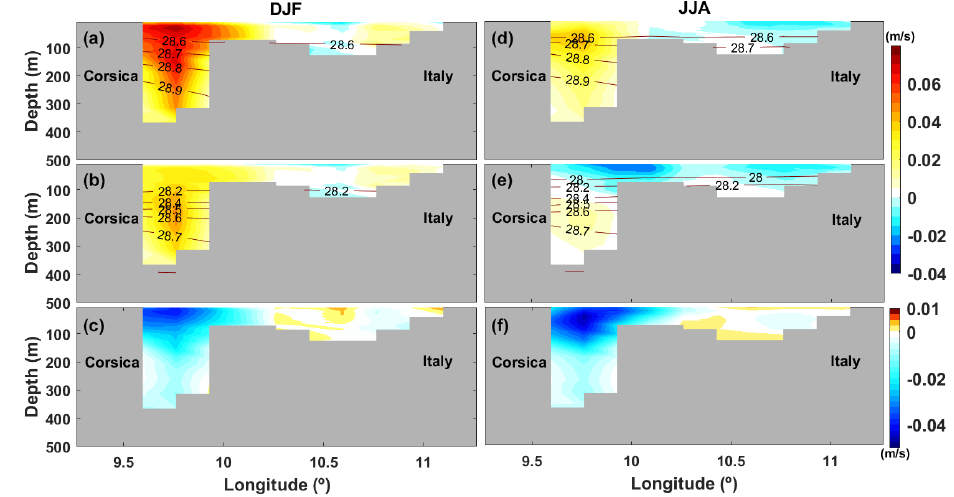
Figure 5. Winter (a–c) and summer (d–f) vertical cross sections of current velocity across the Corsica Channel (42.53 ◦ N, 9.26 ◦ E to 42.80 ◦ N, 11.26 ◦ E; see Fig. 1), in ms − 1 , for present (a, d) and future (b, e) climate as computed from ROM. Positive values indicate northward flow and negative values the opposite. Isopycnals are also depicted. Differences between ocean current velocities in the future and present climate are presented in panels (c) and (f)